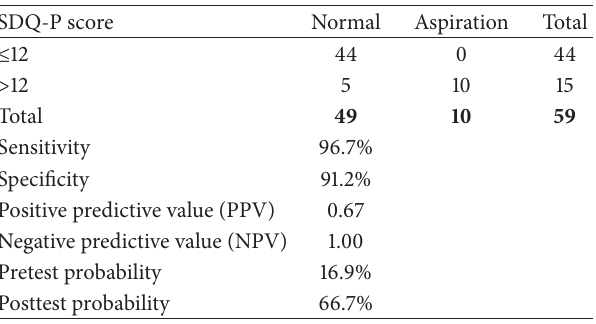
Table 3: Results of the comparison between the Persian version of the questionnaire and videofluoroscopic swallowing